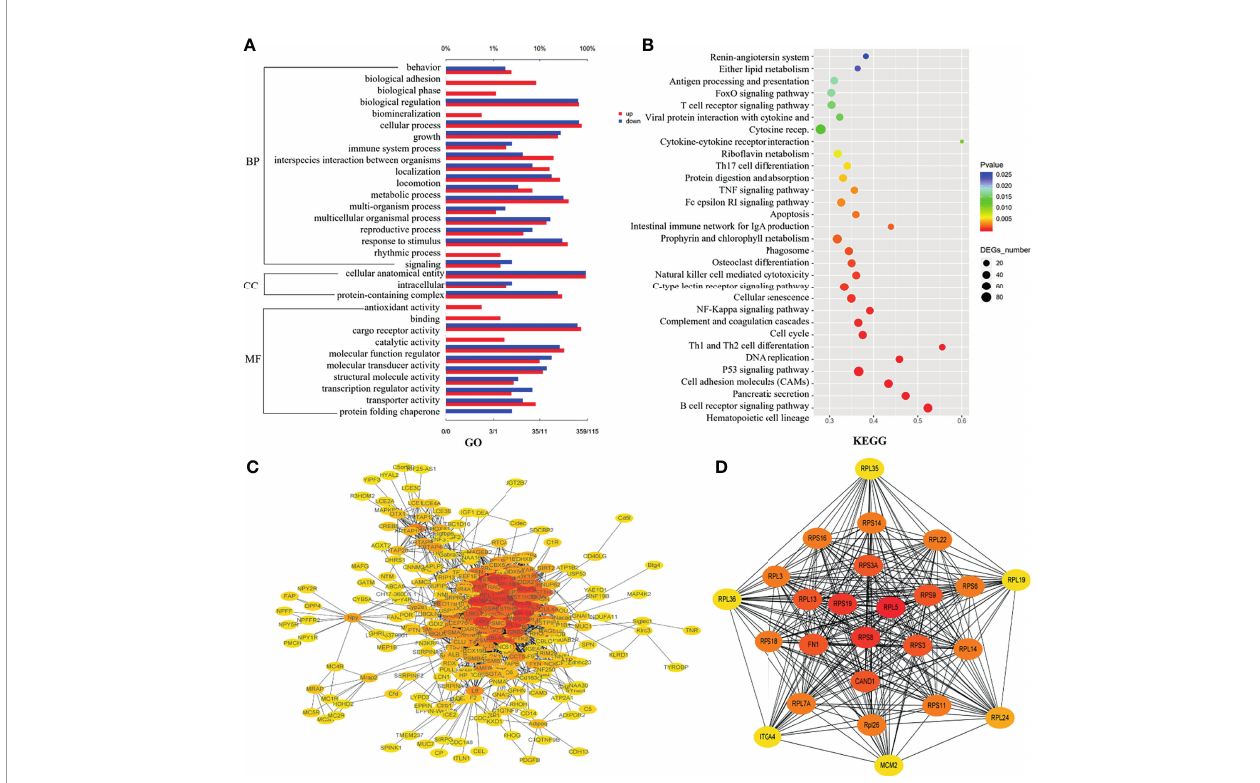
FIGURE 7 | Functional analysis of DEGs. (A) List of enriched Go term on BP, CC and MF. (B) List of enriched KEGG terms. (C) Protein-protein interaction (PPI) network. (D) The subset of PPI network. The top 25 DEGs were selected for magni fi cation according to the degree value. The node color was from yellow to red, and the corresponding degree was gradually larger.